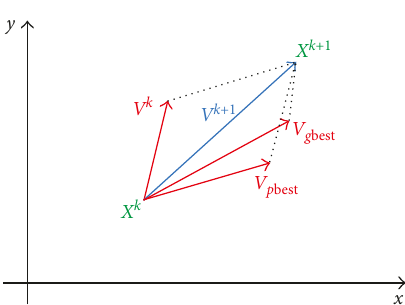
Figure 9: The concept of modifying the search point in